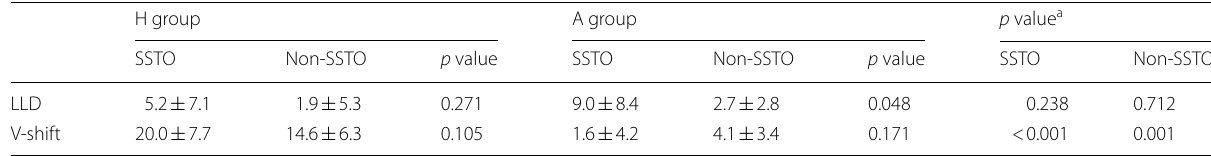
a Difference between the H group and A group in the SSTO and non-SSTO; SSTO, shortening subtrochanteric transverse osteotomy; LLD, leg length discrepancy